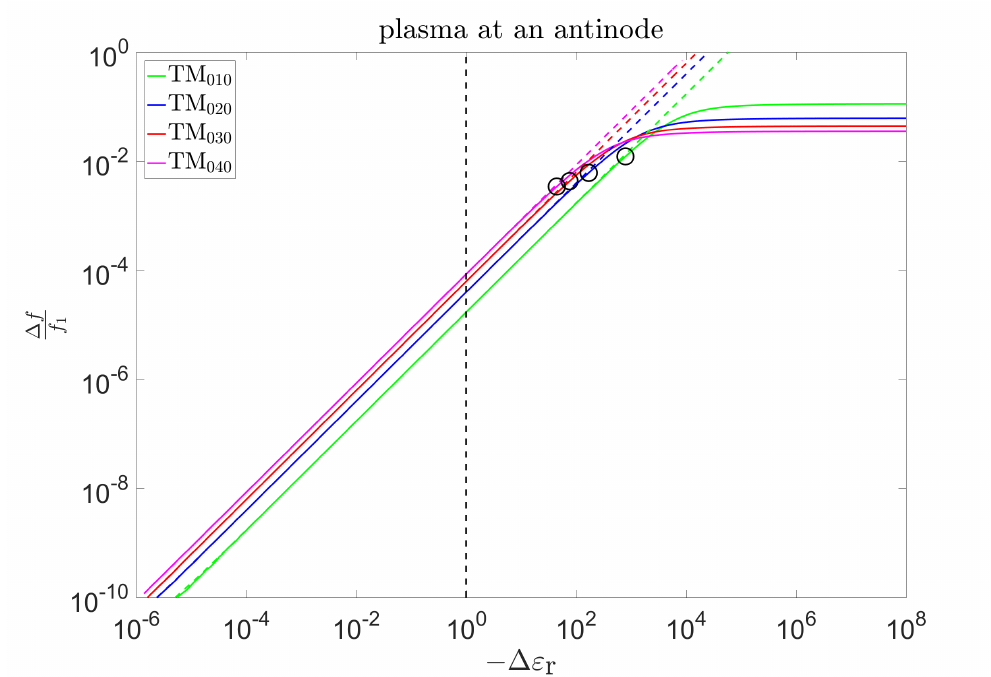
Figure 14. Investigation of the linearity of the relative resonance frequency shift change of the relative permittivity ∆ ε r of the TM 010 and TM 110 mode for four plasma radii. The vertical dashed line at − ∆ ε r = 1 indicates the expanded putative limit of the Microwave Cavity Resonance Spectroscopy (MCRS) diagnostic method and the circles indicate where the response is no longer